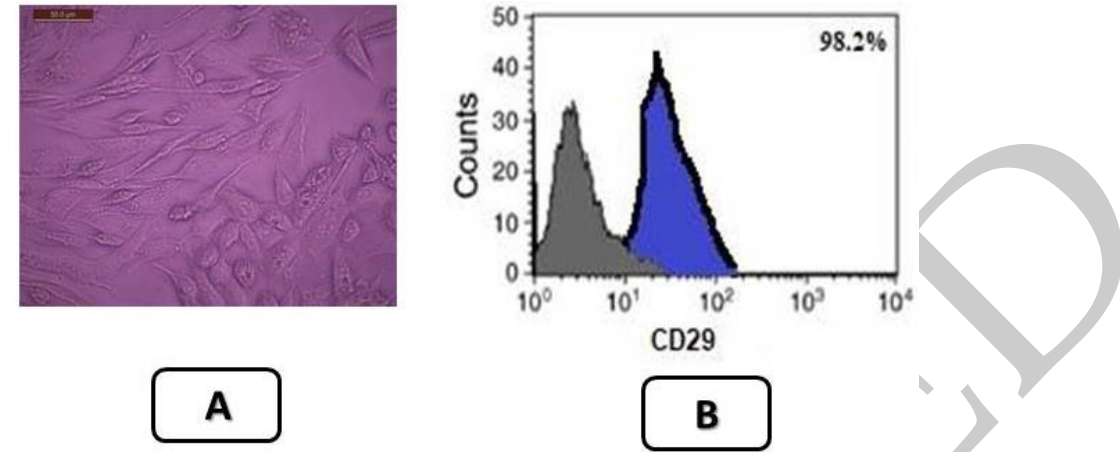
Figure 2. ( A ) Characterization of isolated bone marrow stem cells of rat that were used after 14 days (Mature stage) X200. ( B ) Flow cytometry results of the mesenchymal stem cell marker CD29. MSCs were +ve for CD29 (>98%). The blue area represents the isotype control IgG expression, and gray lines depict the marker expression. The results are representative of three experiments. Data results correspond to the mean ± S.D.